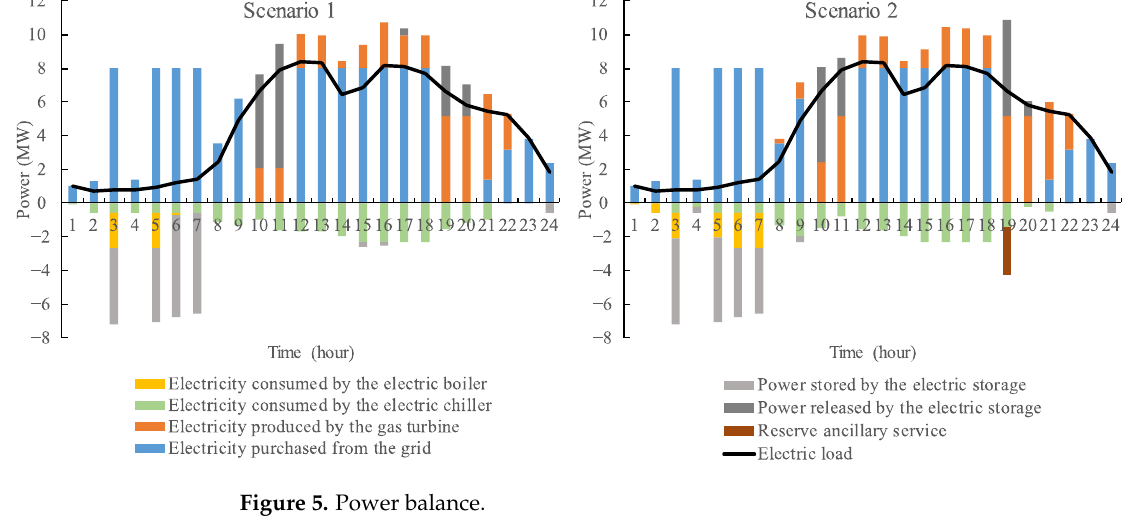
Figure 5. Power balance.